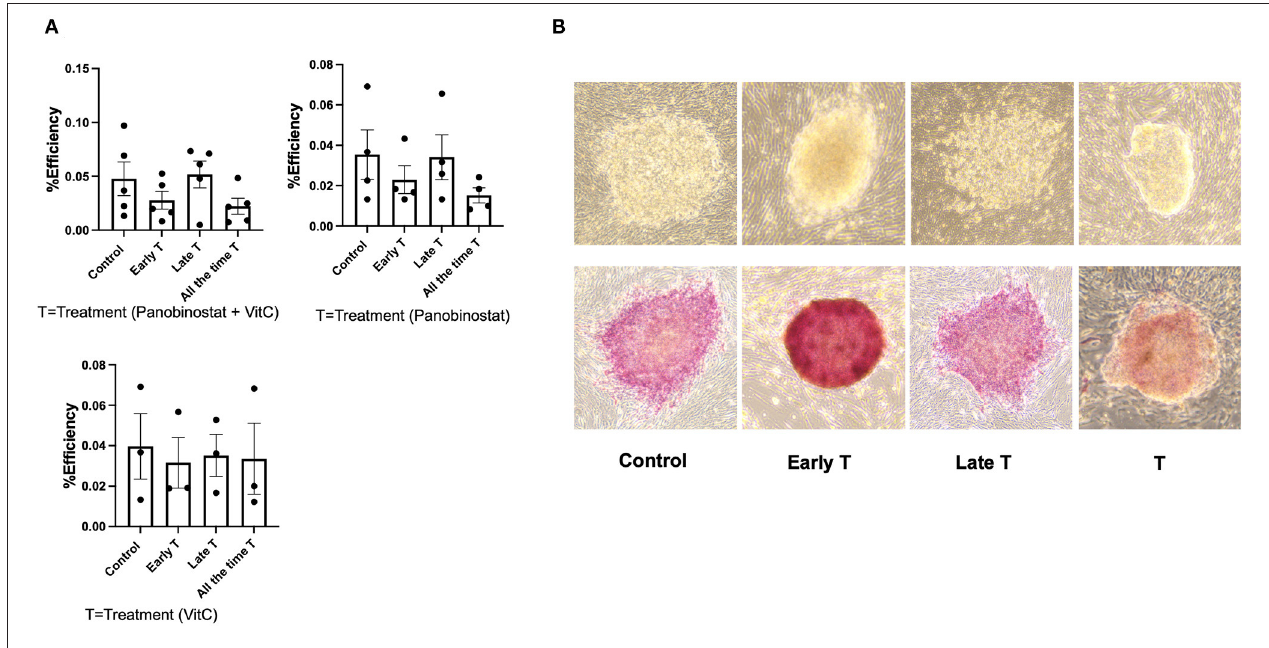
FIGURE 6 | Panobinostat and vitamin C treatment did not change reprogramming efficiency of CEF. (A) Reprogramming efficiency as determined by number of primary iPSC colonies formed, normalized to number of CEF plated. Data are presented as mean ± SEM. Experiment was conducted five times using two different CEF cell lines for panobinostat 1nM and vitamin C treatment group. Experiments were conducted three times for groups treated with panobinostat 1nM only and vitamin C only. We had three different treatment groups based on time that cells received treatment as follows: 1— “All the time T” group was treated with vitamin C (150 µ M) and panobinostat (1nM) from day 1 pi and until end of experiment when primary colonies were counted (14–15 days pi). 2— “Early T” group was treated with same compounds and concentrations from day 1 to 6 and 7 pi, until cells were passed on to an irradiated mouse embryonic fibroblast (iMEF) feeder layer. 3— “Late T” group was treated with same compounds and concentrations, but treatment began after cells was passed on to iMEF and until time point in which primary colonies were counted (14–15 days pi). (B) Top row: Morphology of ciPSC colonies comparing treatment at different time points. Bottom row: alkaline phosphatase staining of ciPSC colonies treated at different